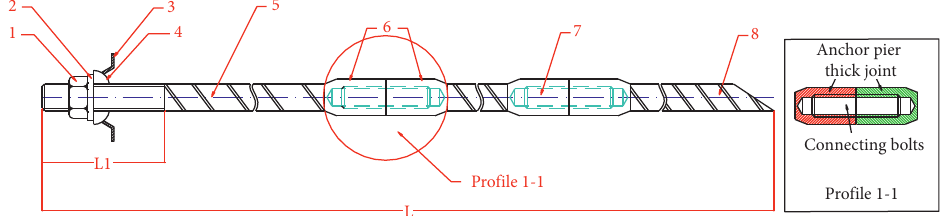
Figure 13: Connected long anchor bolt and accessories.1, nut; 2, plastic washer; 3, tray; 4, ball seat; 5, bolt; 6, upset connector; 7, connecting bolt; 8, anchor